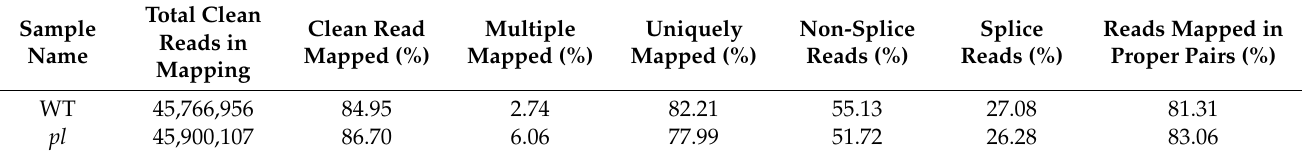
Table 2. Statistical summary of alignment results of RNA-seq used in mapping.